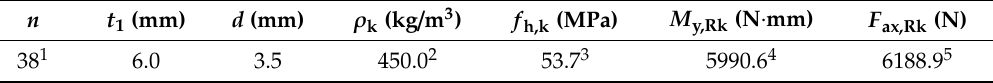
Table 1. Parameters for the characteristic strength of the damper-to-wall connection R Br,k . n t 1 (mm) d